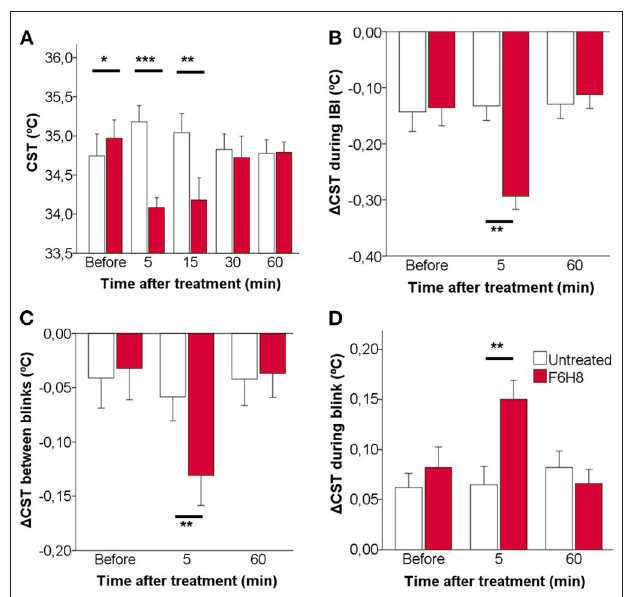
FIGURE 4 | Effects of topical instillation of F6H8 only on the right eye in comparison to the untreated left eye, on CST values measured from infrared thermographic images. (A) CST measured immediately after blink, that is, at the beginning of the interblink interval. (B) CST change during the IBI. (C) CST change between consecutive blinks. (D) CST change during blink. Data are mean ± standard deviation, n = 7; * p < 0.05, ** p < 0.01, *** p < 0.001, paired t